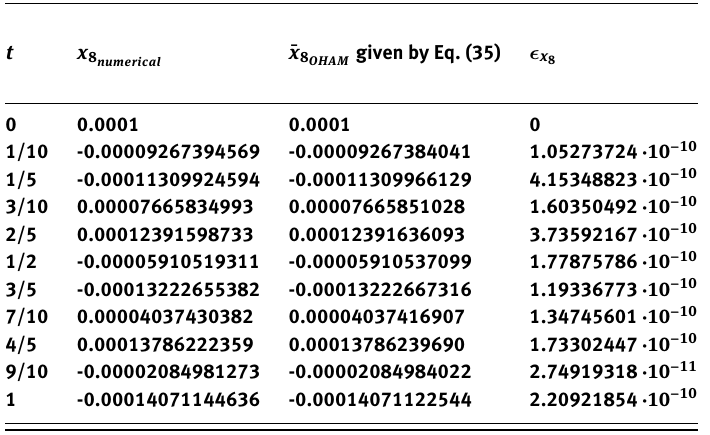
Table 3. The comparison between the approximate solutions ¯ x 8 given by Eq. (35) and the corresponding numerical solutions for M = 15 and P = 20 (relative errors: (cid:15) x